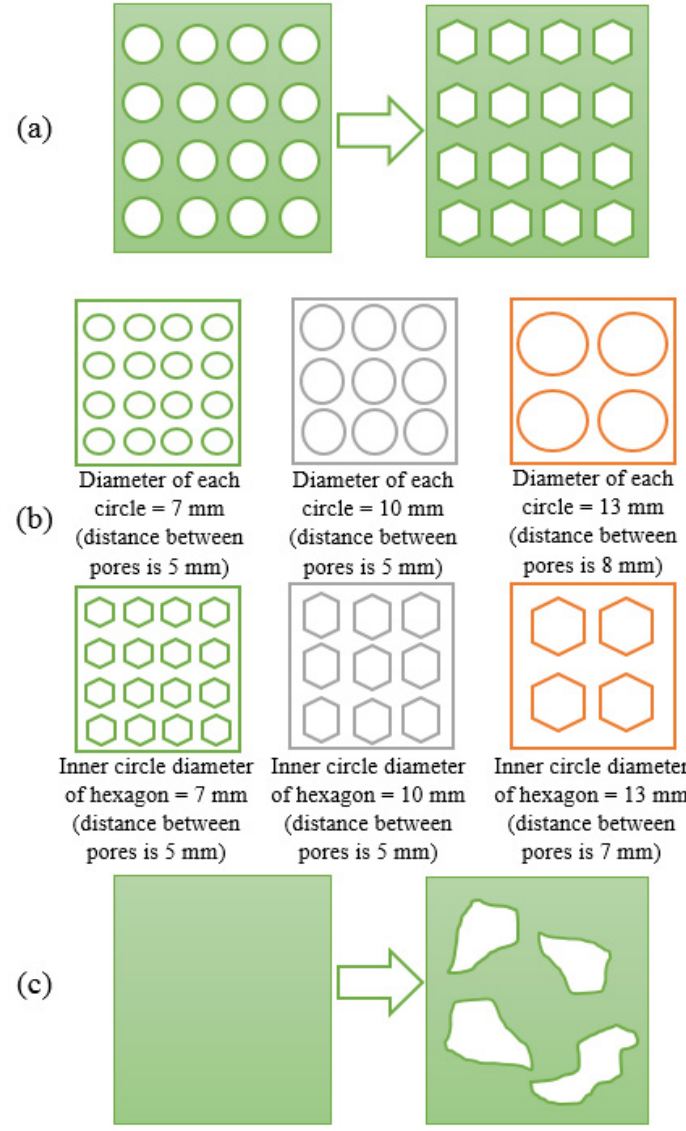
Figure 3. Considered case studies: ( a ) Case 1; ( b ) Case 2; ( c ) Case 3.